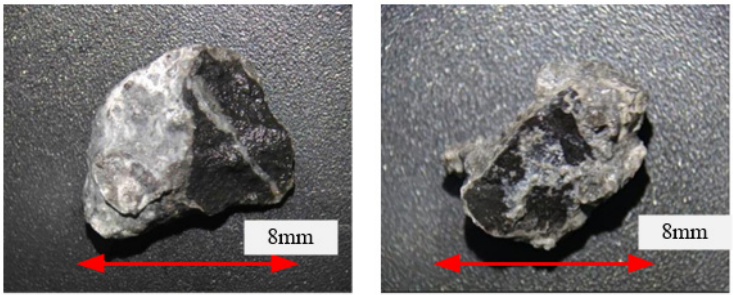
Figure 5. Structure of aggregate paste falling off.